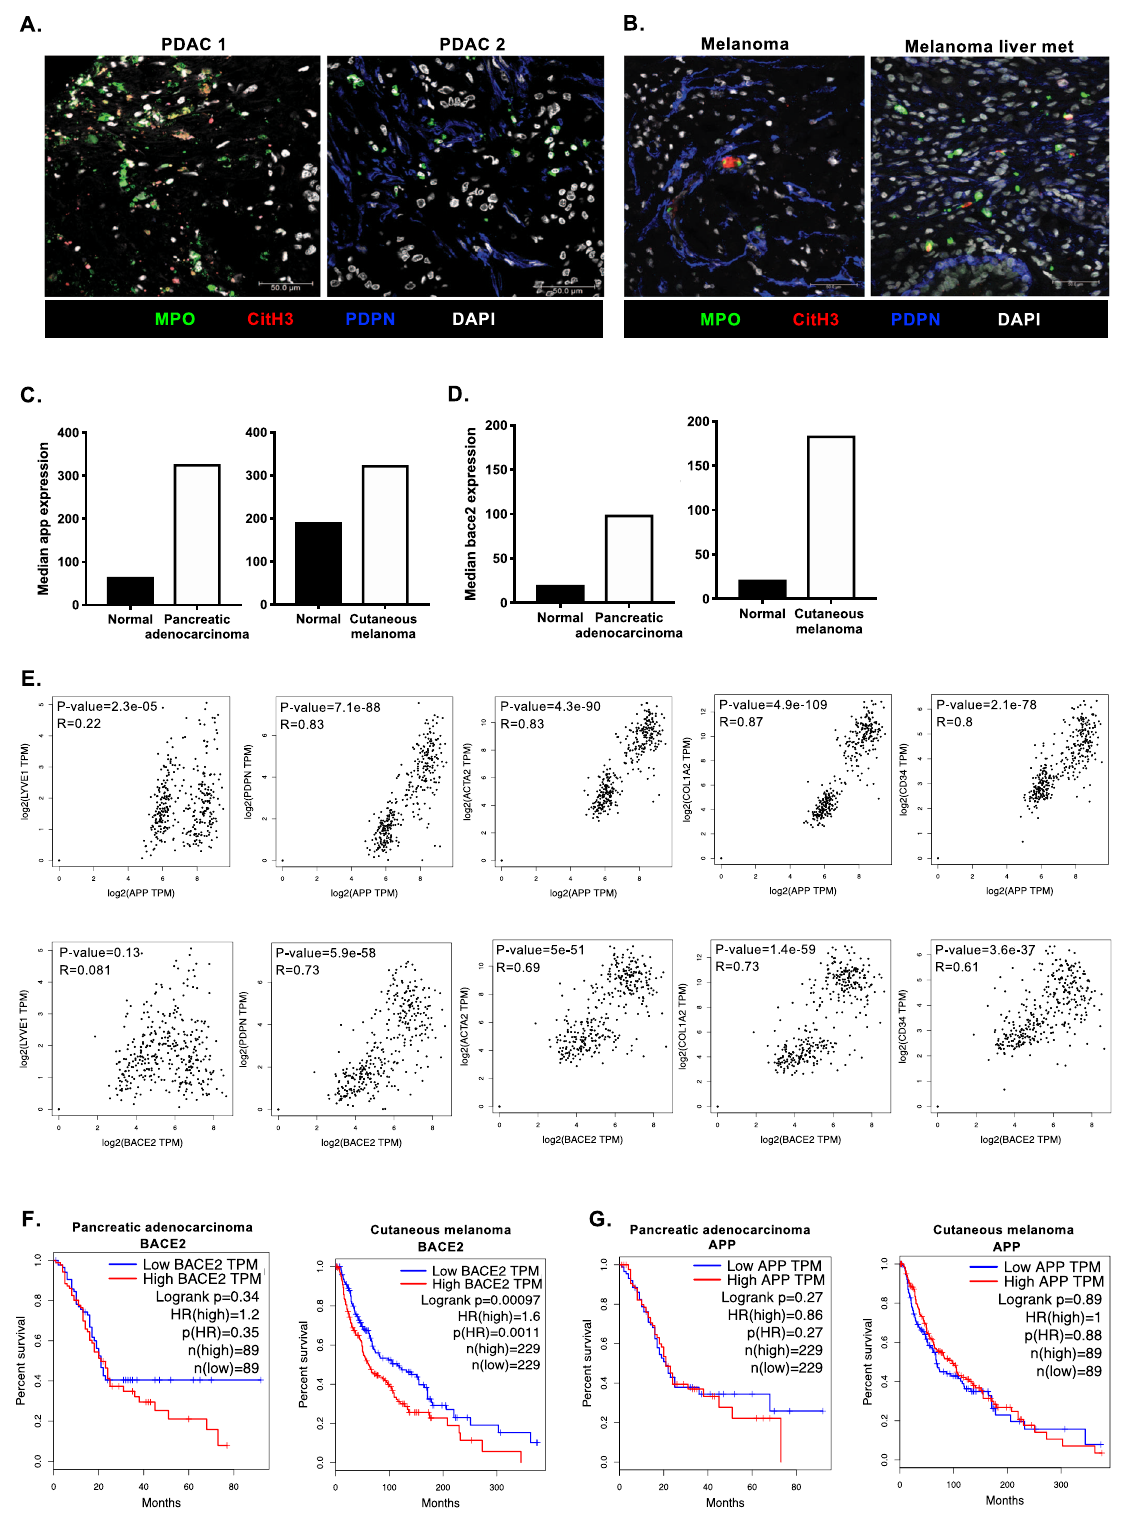
Methods Mice . The care and use of all mice in this study were in accordance with the UK Animals in Science Regulation Unit ’ s Code of Practice for the Housing and Care of Animals Bred, Supplied or Used for Scienti fi c Purposes, the Animals (Scienti fi c Procedures) Act 1986 Amendment Regulations 2012. All procedures were performed under a UK Home Of fi ce Project license (PPL 80/2574 or PPL P88378353), which were reviewed and approved by the Medical research Council Laboratory of Mole- cular Biology (PPL 80/2574 or PPL P8837835) Animal Welfare and Ethical Review